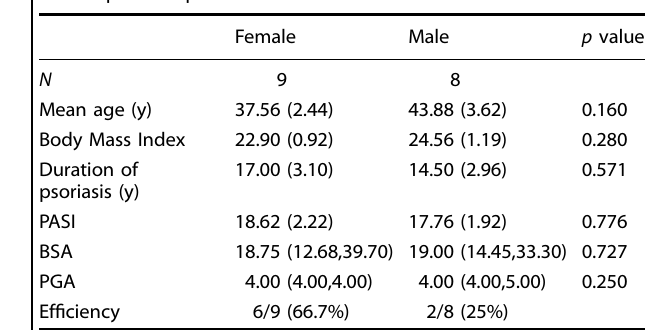
Table 3. Comparison of baseline characteristics between male